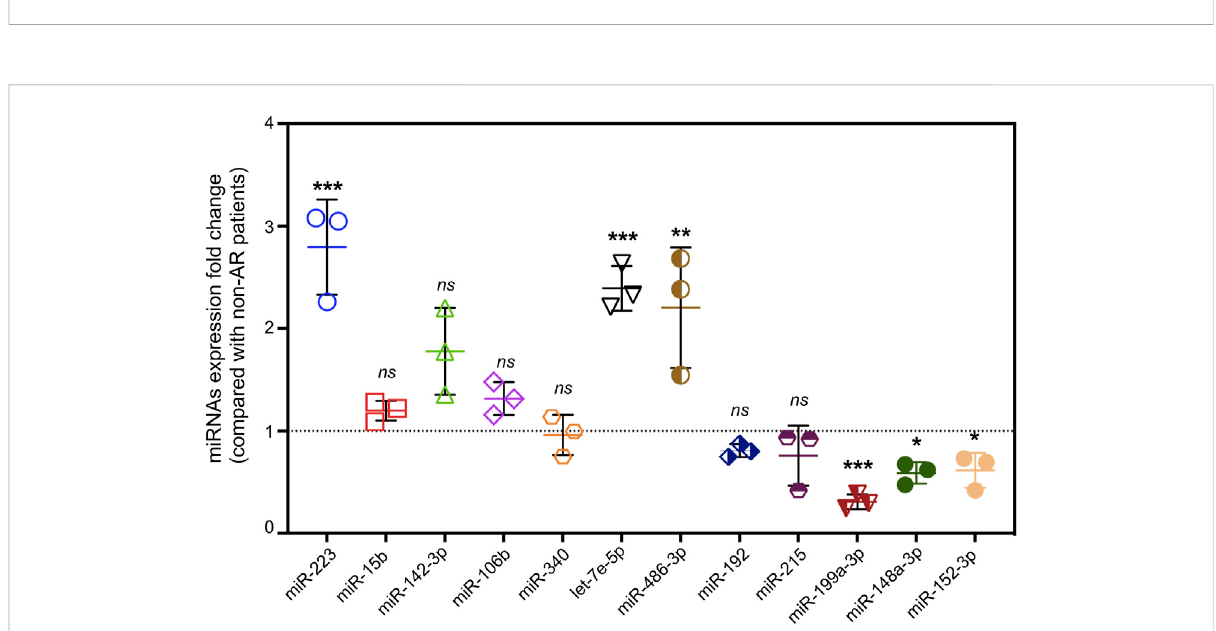
FIGURE 7 Validation ofdifferentialexpressedmiRNAsbyqRT-PCR.miRNAexpressionoffold change detectedbyqRT-PCR inARpatients comparedwith non-AR patients ( n = 3, p * < 0.05, p ** < 0.01, p *** < 0.001, ns = no signi fi